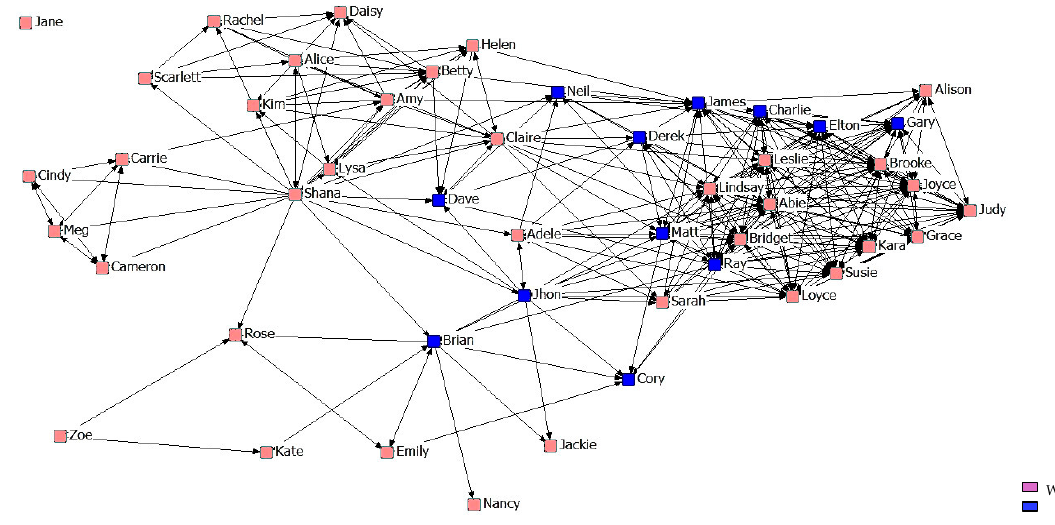
Figure 6. Graph of the first year Maximum Friendship Network.